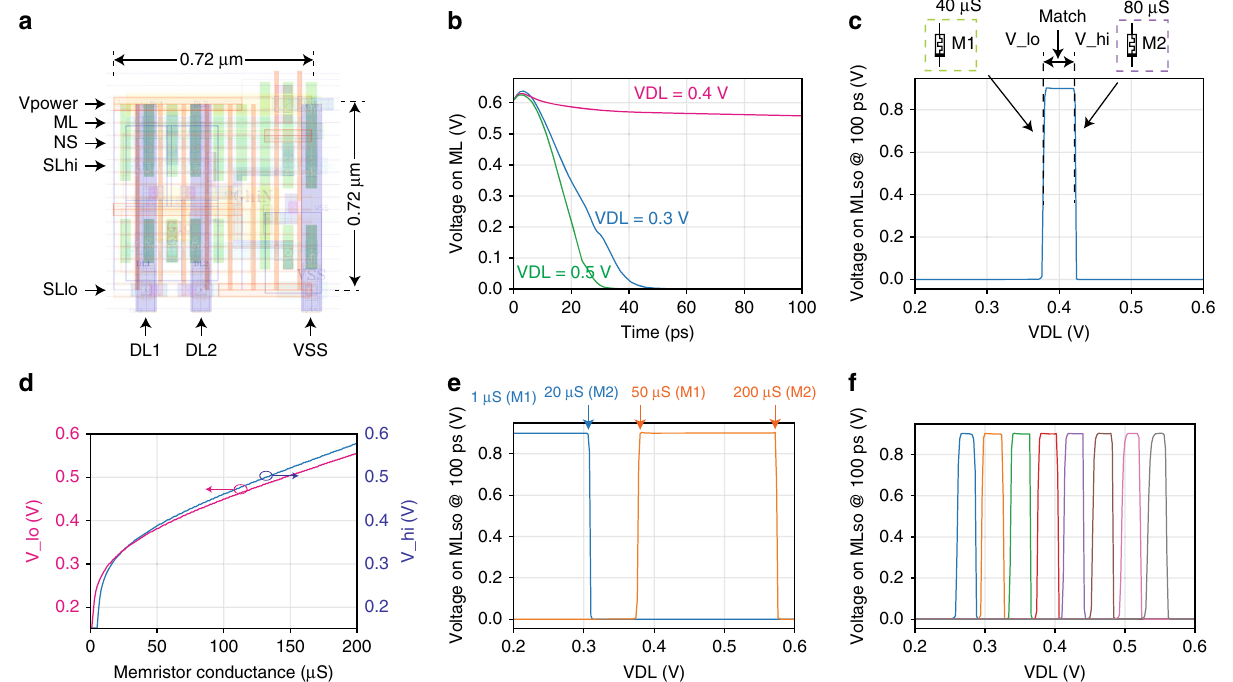
Fig. 3 Simulations of the memristor analog content-addressable memory cell. a The layout design of one analog content-addressable memory (CAM) cell in an analog CAM array using commercial 16 nm design rules. The transistors in this proof-of-concept design are over-sized to allow large driving currents. b Simulated transient voltage response on the Match Line (ML) where the different curves show searches with different Data Line (DL) voltages for a matching case (red) and two mismatching cases (blue, green). c The circuit simulation with the same memristor con fi guration shown in ( b ) shows that the cell matches a range of DL voltage, whose bounds are independently controlled by the conductances of the two memristors in the cell. d The simulated relation between the search range and the memristor conductance. The blue curve shows the lower bound of the stored range, while magenta shows the upper bound. e , f Using differently con fi gured memristor conductances, the cells in the array can store ( e ) a continuous range of values, or ( f ) discrete levels (showing eight levels or